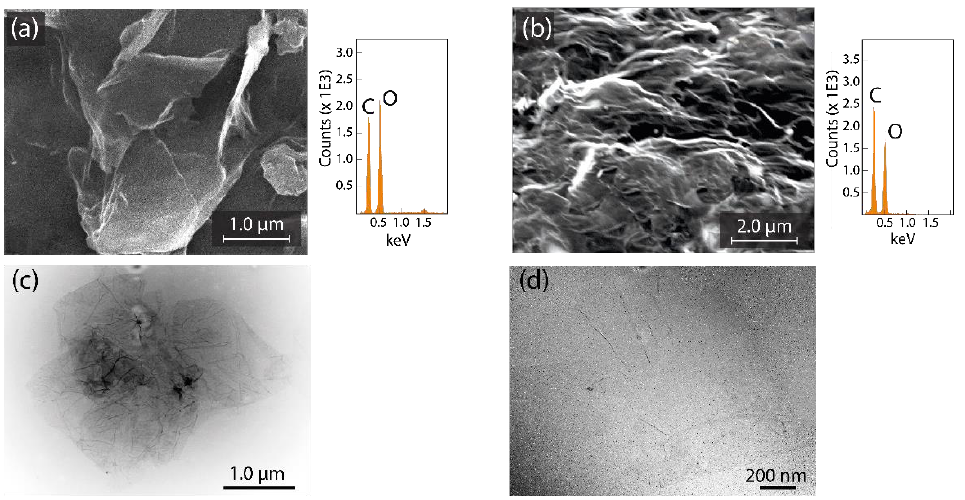
Figure 2. SEM images and EDS measurements of ( a ) GO and ( b ) rGO. TEM images of ( c ) GO and ( d ) rGO.